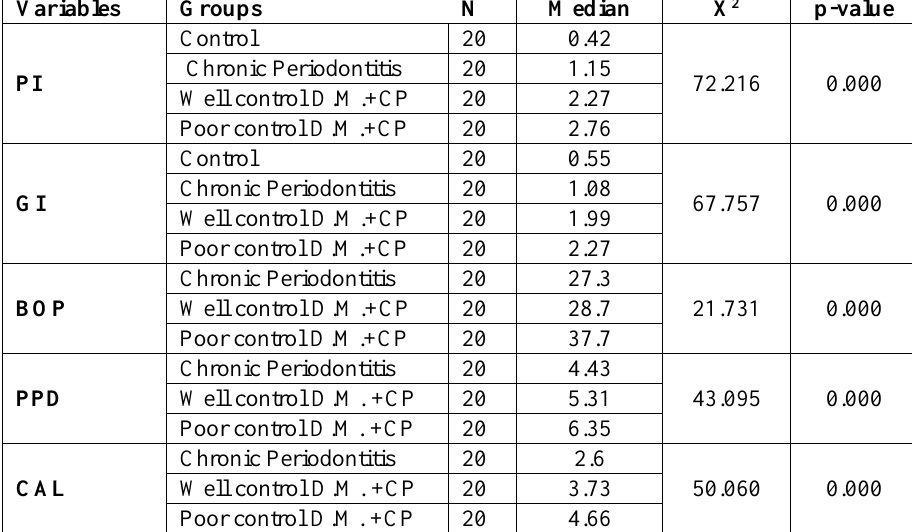
Table 1: Analytic statistics in clinical parameters for the study and control groups